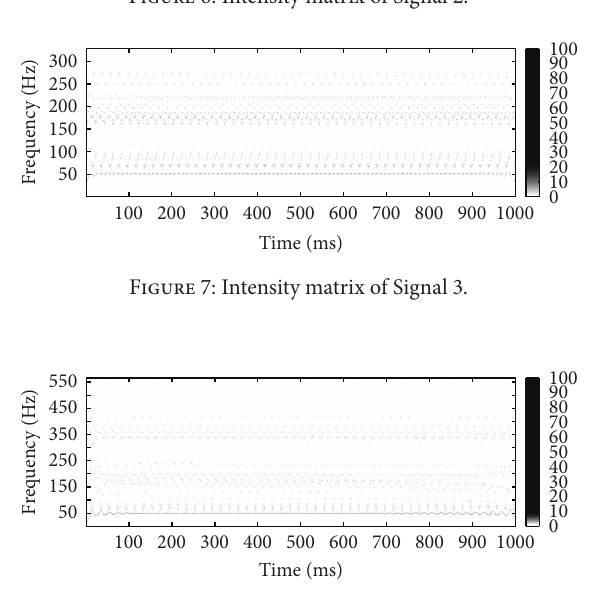
Figure 6: Intensity matrix of Signal 2.